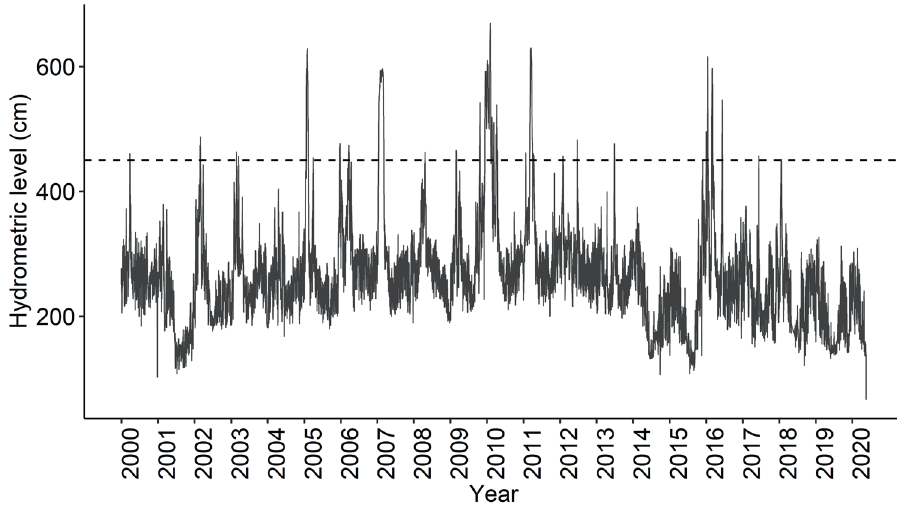
FIGURE 2 | Daily variation in the level of the Paraná River between 2000 and 2020 (provided by the Agência Nacional de Águas e Saneamento Básico - ANA). The horizontal line represents the 4.5 m level when the Paraná River